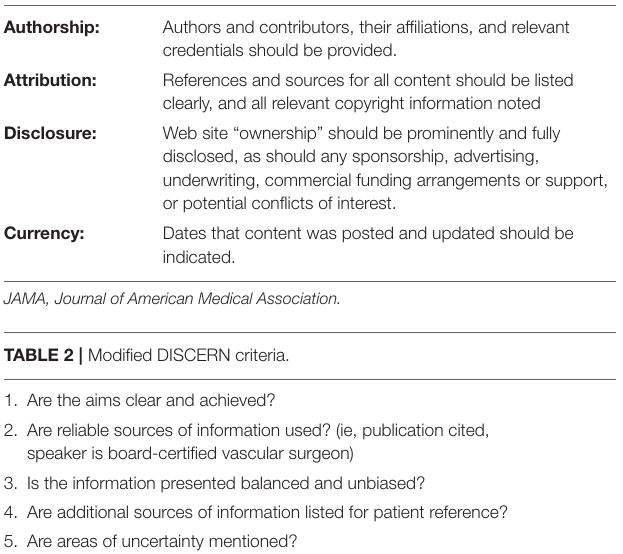
TABLE 1 | JAMA Score benchmark criteria.